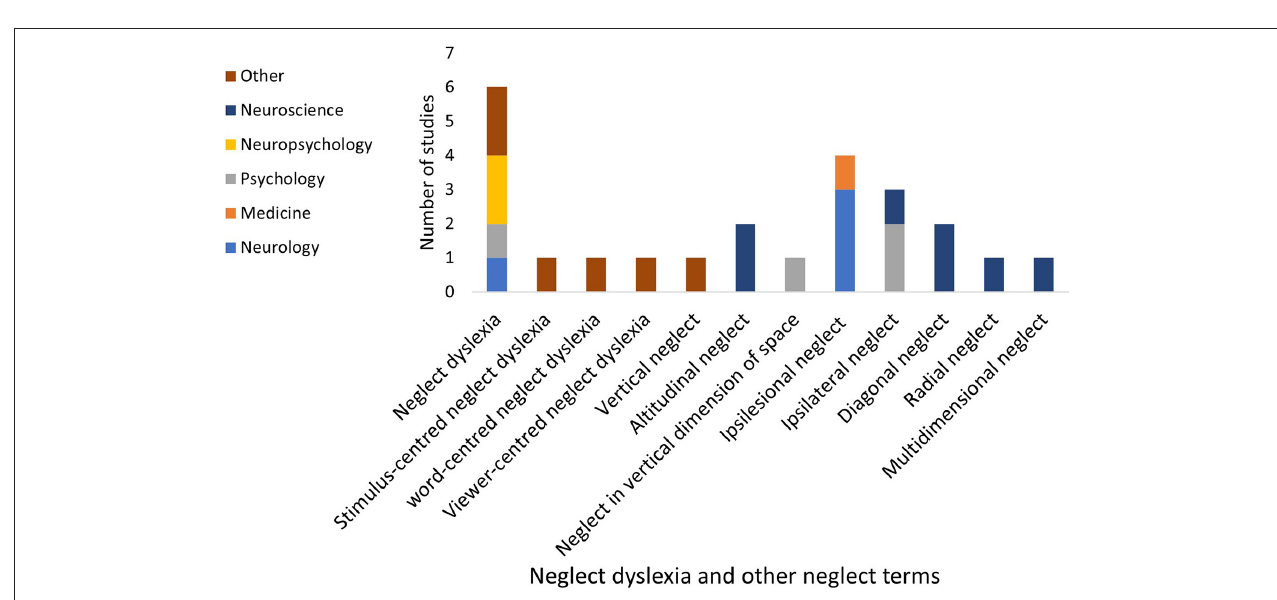
FIGURE 9 | Neglect dyslexia and other neglect terms used within included